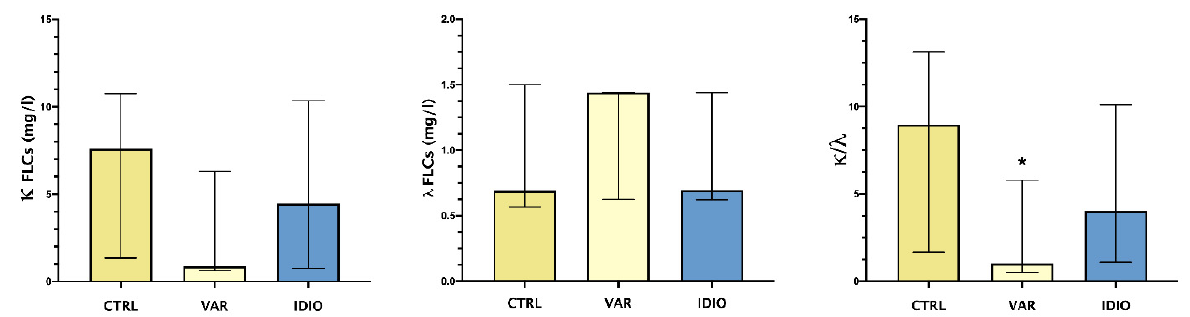
Figure 1. FLCs in the studied groups: median and IQ ranges of seminal plasma levels of κ and λ FLCs and their ratio. Controls seminal fluids (CTRL), varicoceles (VAR), idiopathic oligo- asthenozoospermia (IDIO). * p < 0.05.